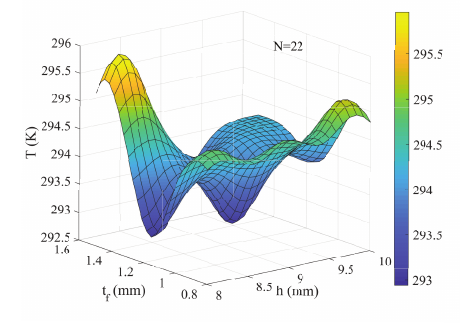
Figure 8. Behavior of T as function of t f and h .